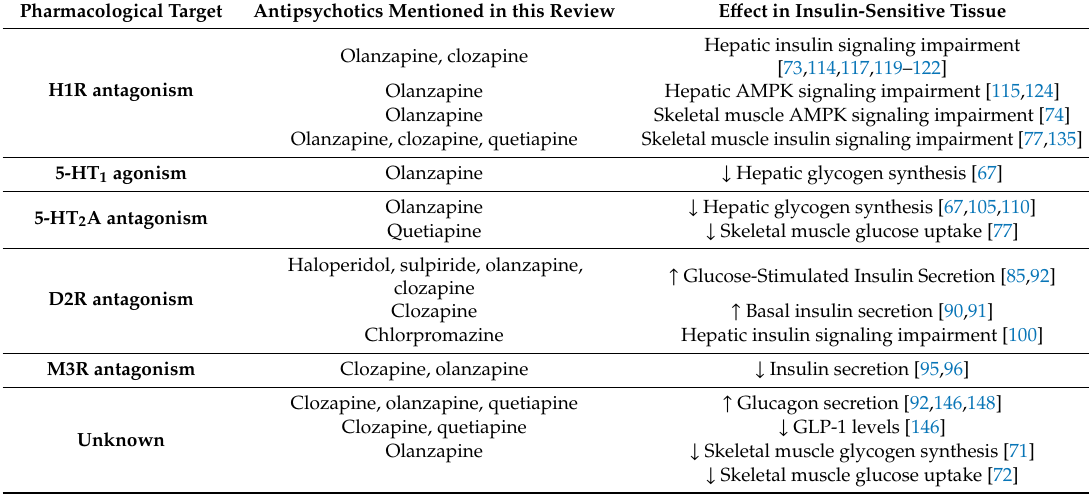
Table 1. List of mentioned APDs e ff ects on peripheral insulin-sensitive tissues inducing dysregulation in glucose